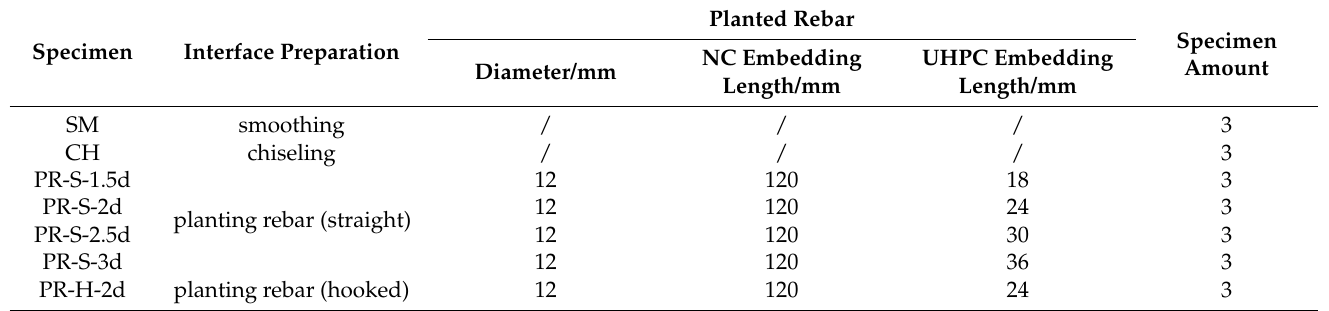
Table 1. UHPC–NC push-out test